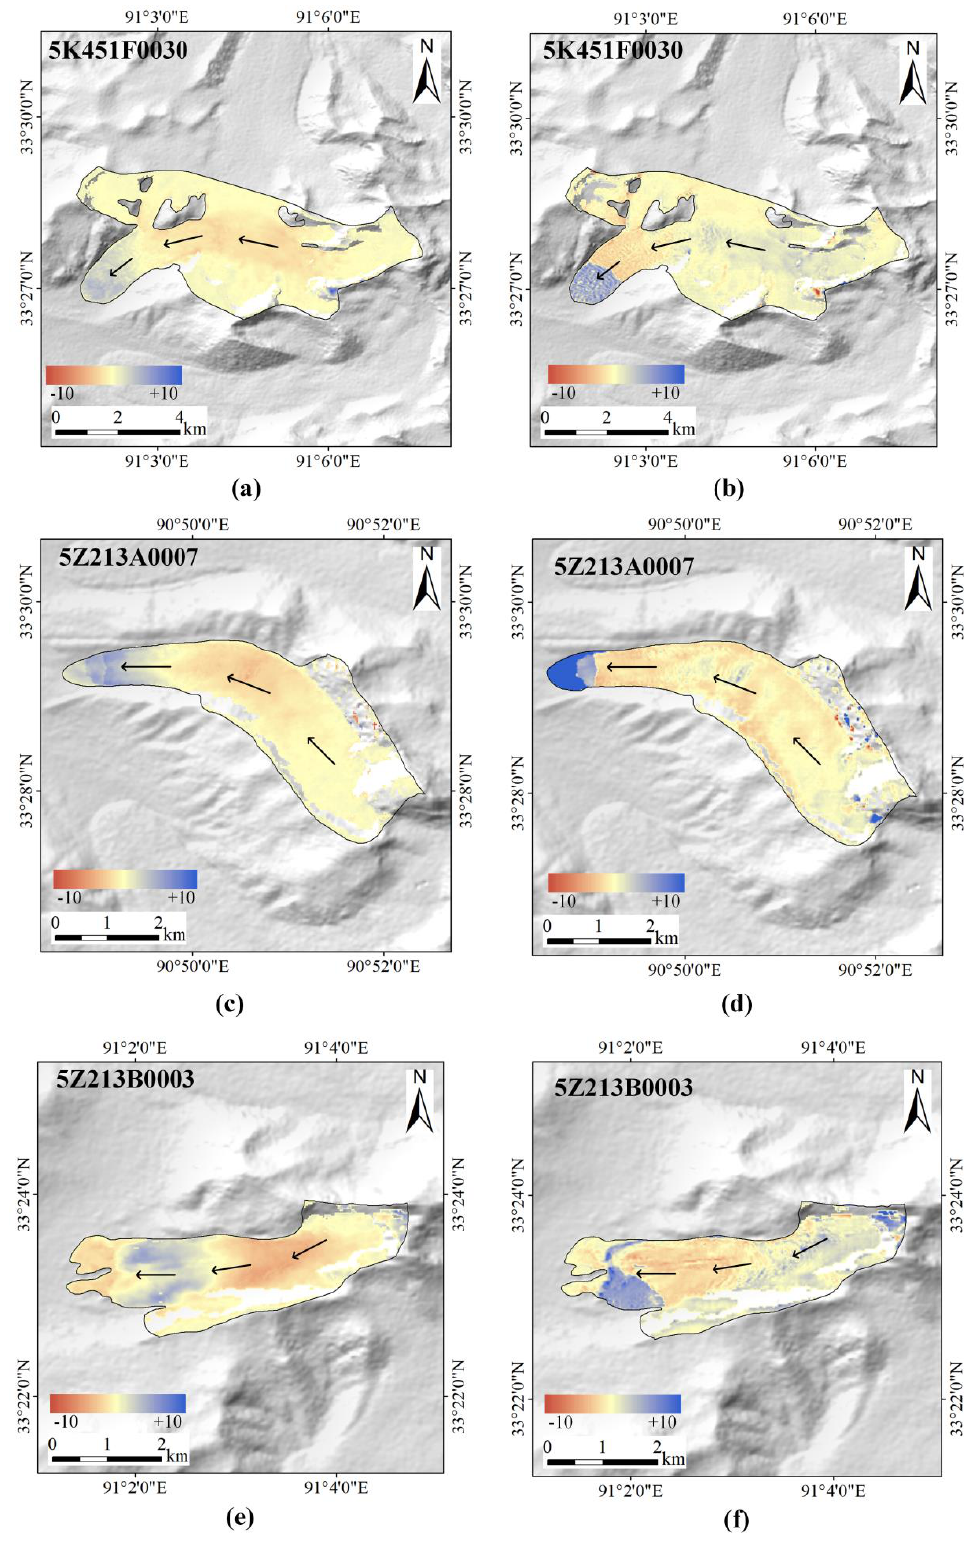
Figure 6. Observed annual glacier elevation changes (m yr − 1 ) over three surge-type glaciers of 5K451F0030, 5Z213A0007, and 5Z213B0003. ( a ), ( c ) and ( e ) are the observations in the period 2000 − 2012; ( b ), ( d ) and ( f ) are the observations in the period 2012 − 2018. Black arrows indicate the directions of glacier surface